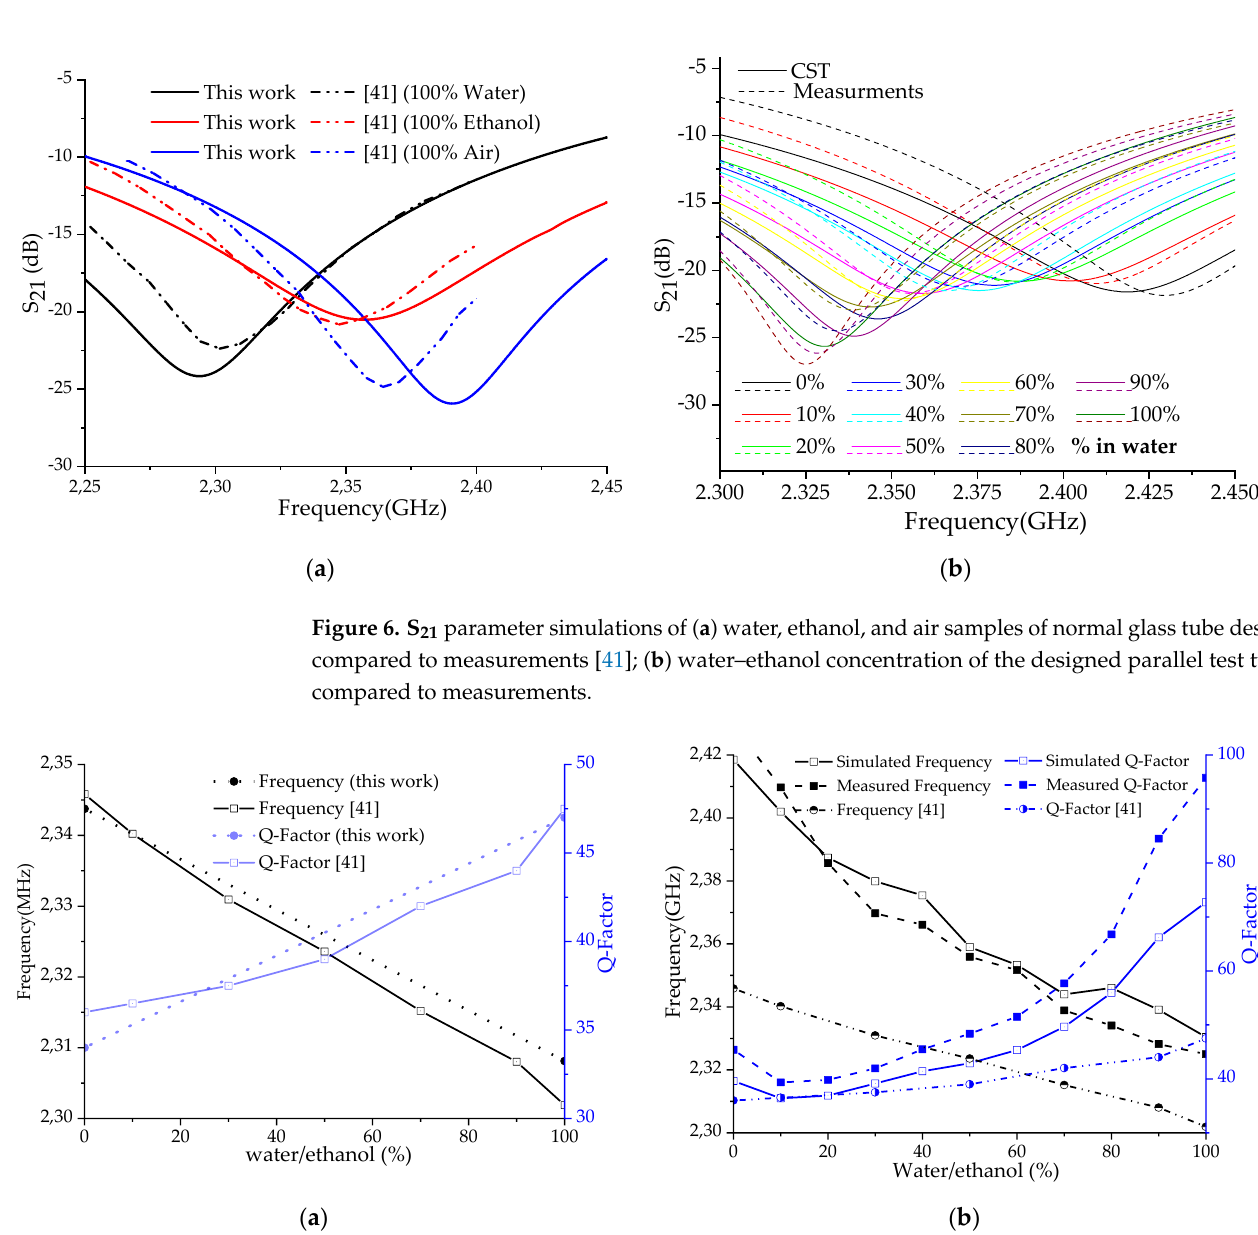
Figure 7. Q factor and resonant frequency versus water–ethanol concentration of ( a ) normal glass tube design compared to measurements [41], and ( b ) the designed parallel test tube compared to measurements.